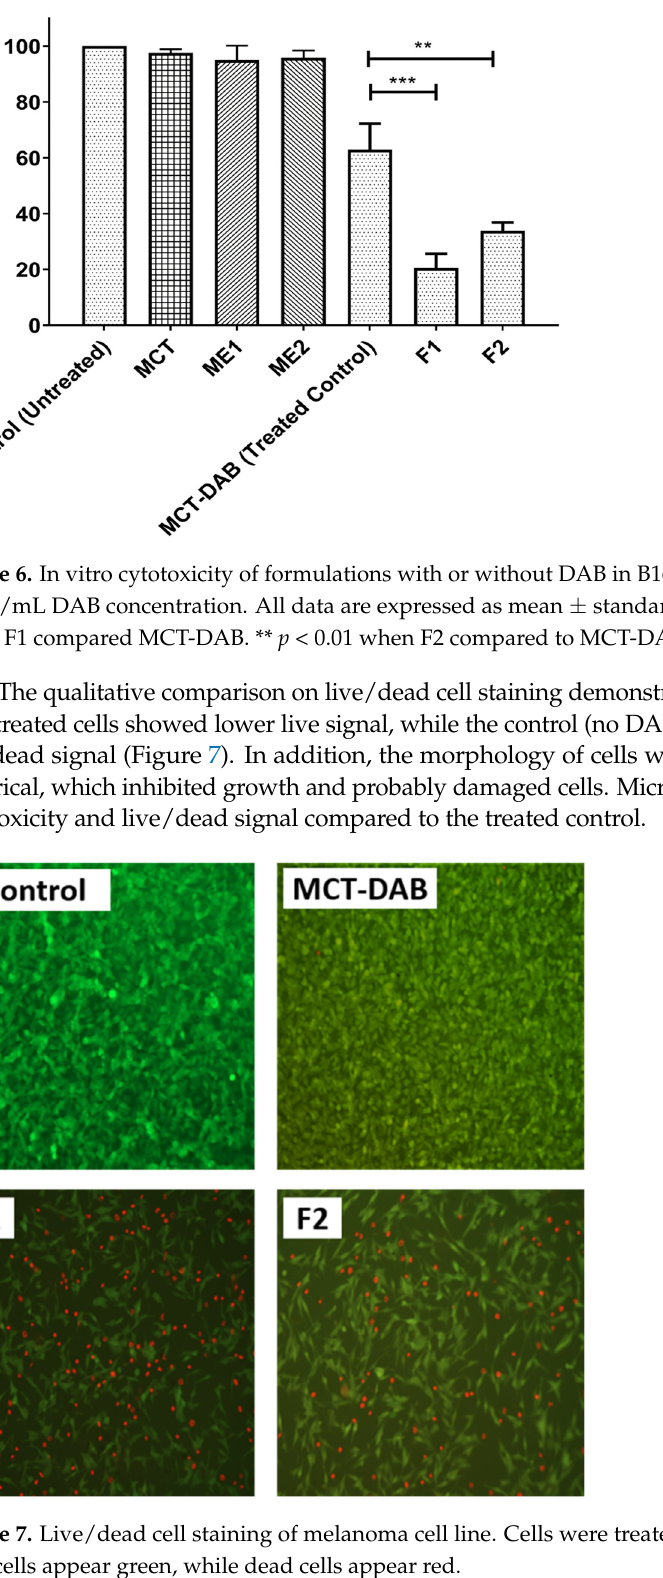
Figure 5. Cytotoxic e ff ect of DAB on the B16BL6 cell line. Cells were incubated with various concen- trations for 24 h. All data are expressed as mean percentages to untreated control cells (n = 3).